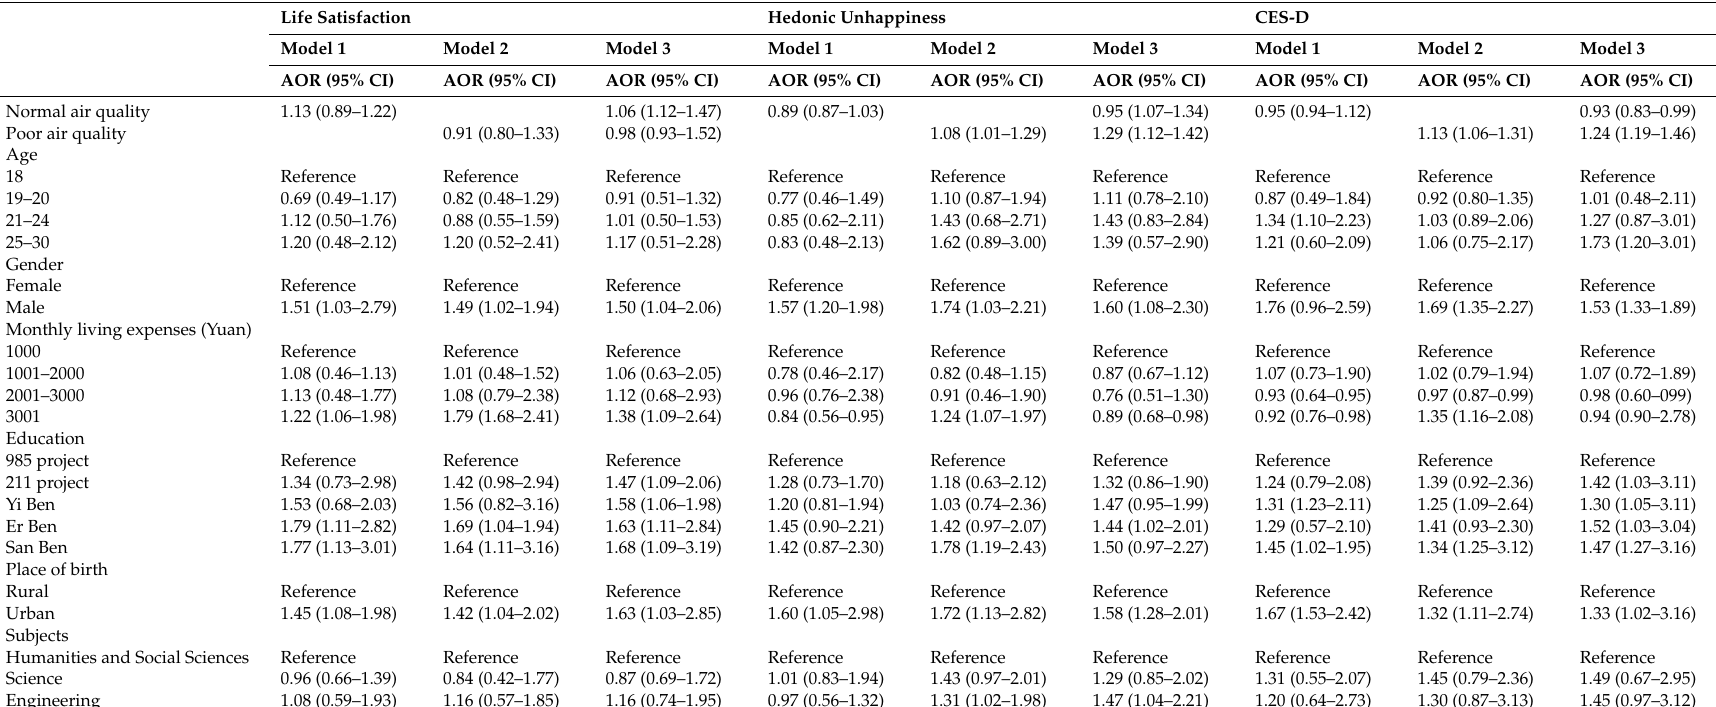
Table 3. Multivariable associations of psychological well-being as a dichotomous